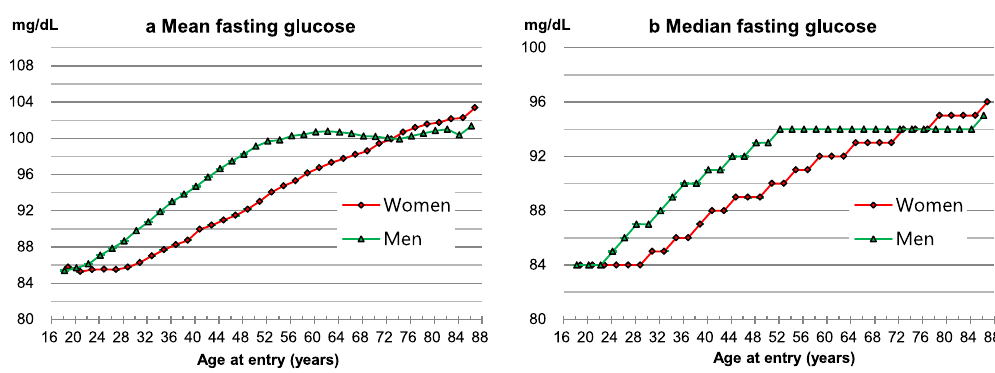
Figure 1. Mean and median concentration of fasting glucose. To convert glucose from mg/dL to mmol/L, multiply by